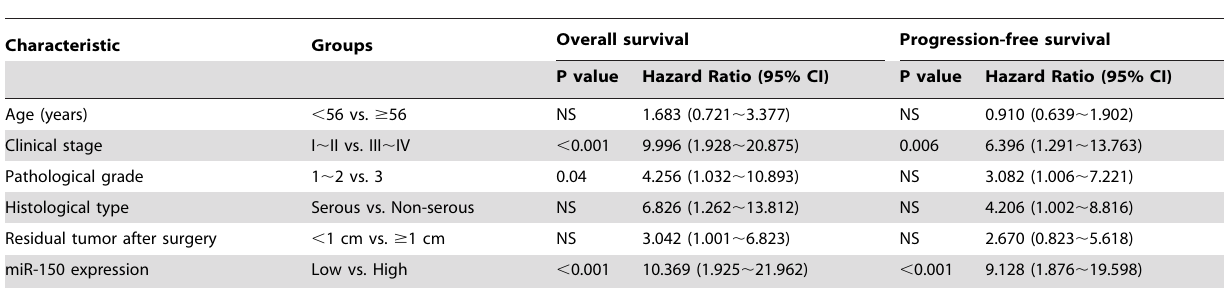
Table 2. Univariate analysis: factors predicting overall and progression-free survival.